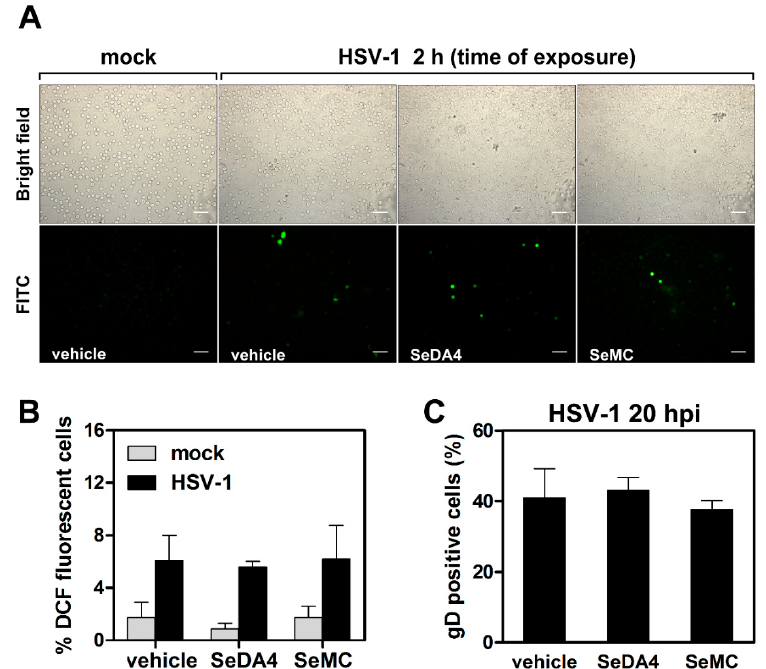
Figure 8. E ff ects of selenium-based antioxidants on monocytic cells with abrogated NF-KB activity and exposed to HSV-1. U937-DN-IkB were incubated with SeDA4 (20 µ M), SeMC (20 µ M) or vehicle alone for 48 h and then preloaded with DCFH-DA before infection with HSV-1 (MOI = 50 PFU / cell) and successive fluorescence microscopy analysis. ( A ) Representative images of cells collected at 2 h post infection. 20 × objective. Scale bar = 50 µ m. ( B ) Quantification of results shown in A by analyses from 8 frames randomly selected from two separate experiments (4 frames each). ( C ) Evaluation of gD-HSV-1 expressing cells by immunofluorescence microscopy analysis of cells collected at 20 h post infection. Each bar represents the mean value + S.D. of three independent experiments. No significant di ff erences among infected cells either for ROS production ( B ) or for infectivity rate ( C ). Viruses 2019 , 11 , x FOR PEER REVIEW